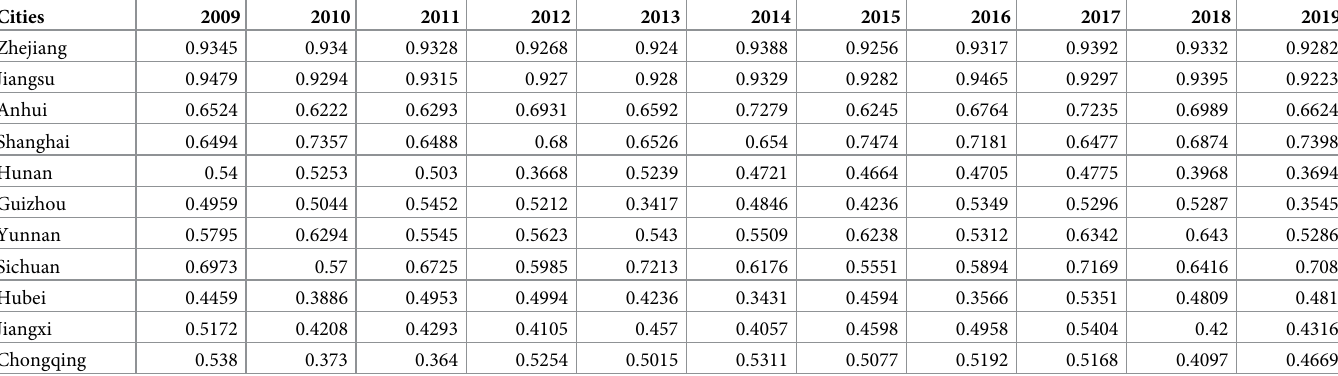
Table 3. Urbanization system comprehensive index value for various